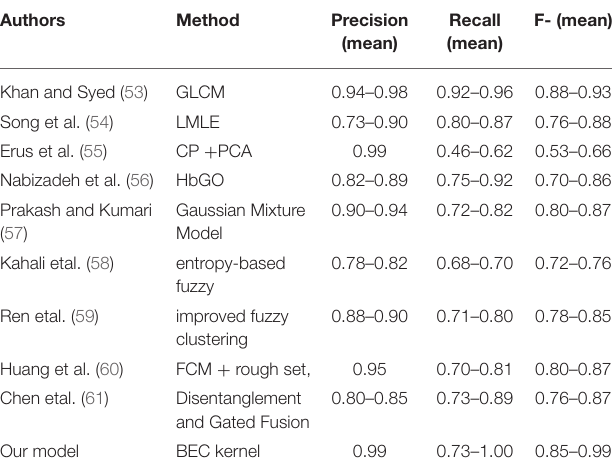
TABLE 9 | Our prediction model compared with reference